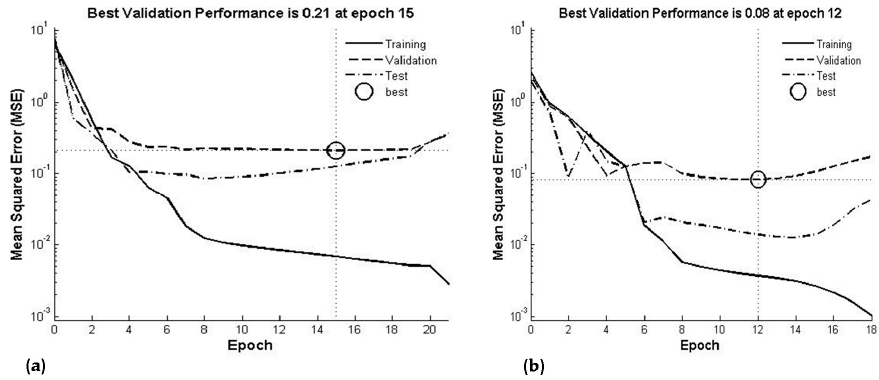
Figure 5. Mean squared error (MSE) curve of ( a ) pH and ( b ) EC optimal ANN model at the phase of learning for training, validation, and test datasets, respectively. Table 7. Optimal ANN model performances and parameters for soil pH and EC estimations. RMSE Predictive Model Parameters Predictor Variable Combination Tra. Val. Test Tra. Val. Test